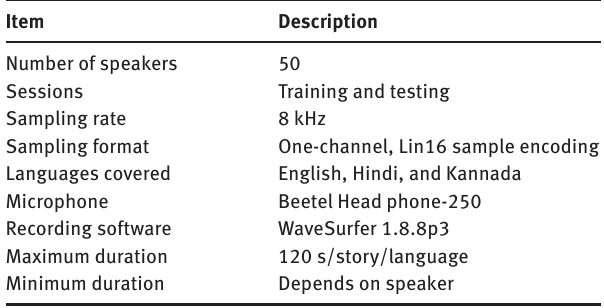
Table 1: Description of Database.